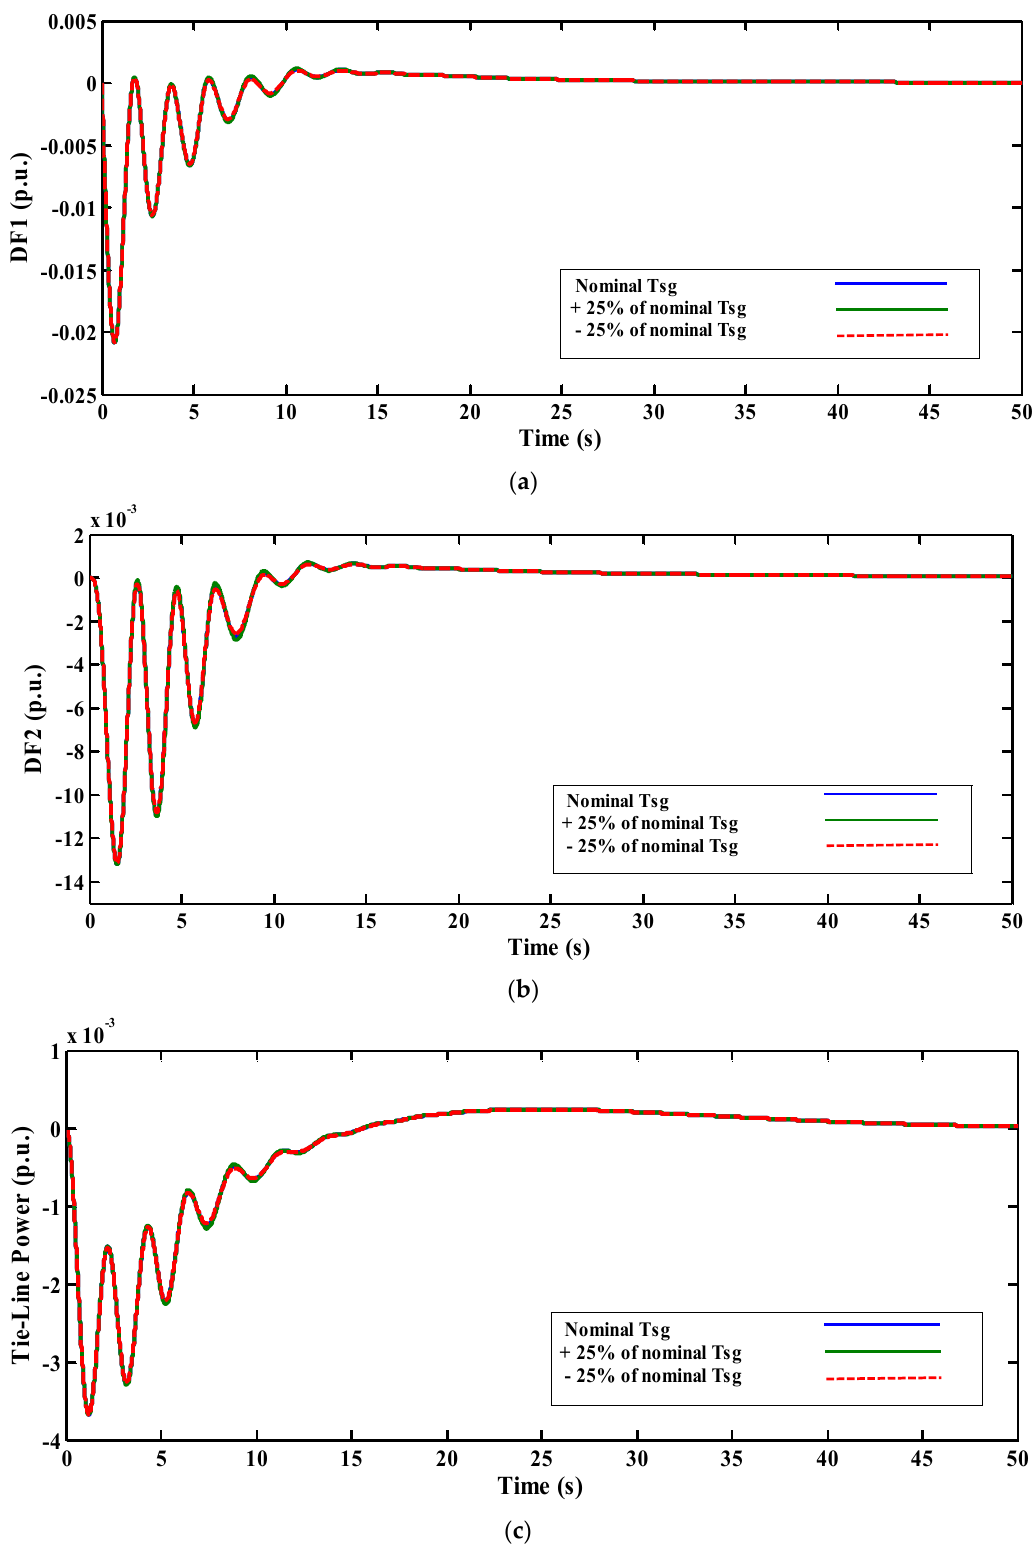
Figure 9. Simulation results for ± 25% of time constant of steam turbine, ( a ) frequency deviation in area 1; ( b ) frequency deviation in area 2; and ( c ) tie ‐ line power deviation. Table 4. Frequency deviation and tie ‐ line power characteristics of FOPID controllers for ±25% variations in the time constant of steam turbine and synchronizing coefficient.